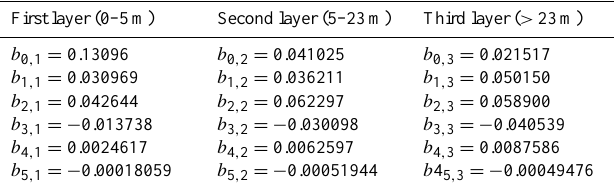
Table 2. Coefficients for use in the Anderson (1993) calculation of light attenuation (Eq.